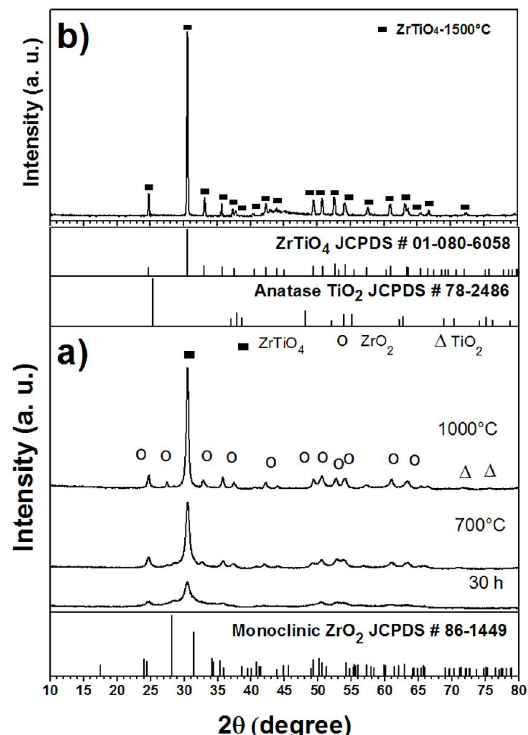
Figure 2. XRD patterns of balled-milled samples for 30 h treated at different temperatures for 6 h, (a) 700-1000 ºC, and (b) 1500 ºC. Figure 2b shows the XRD pattern of the ball-milled sample for 30 h after heat treatment at 1500 ºC for 6 h. A single and highly crystalline phase, identified as ZrTiO (PDF 00-01-080- 6058), was